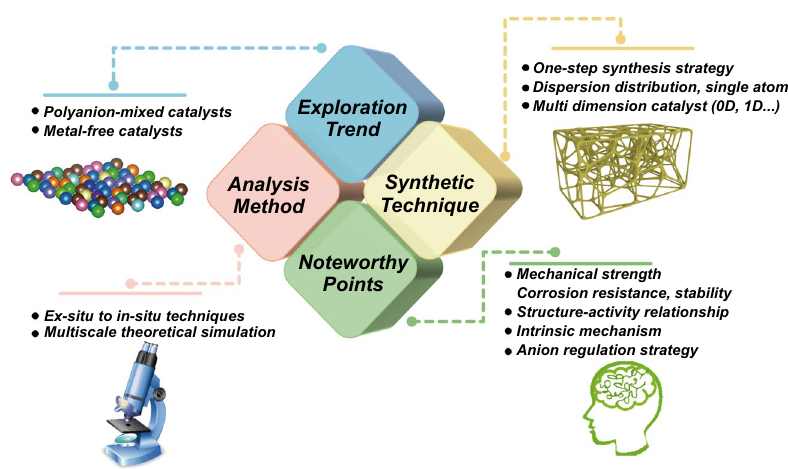
Fig. 16 Outlook and perspective research directions for anion-mixed catalysts served for water